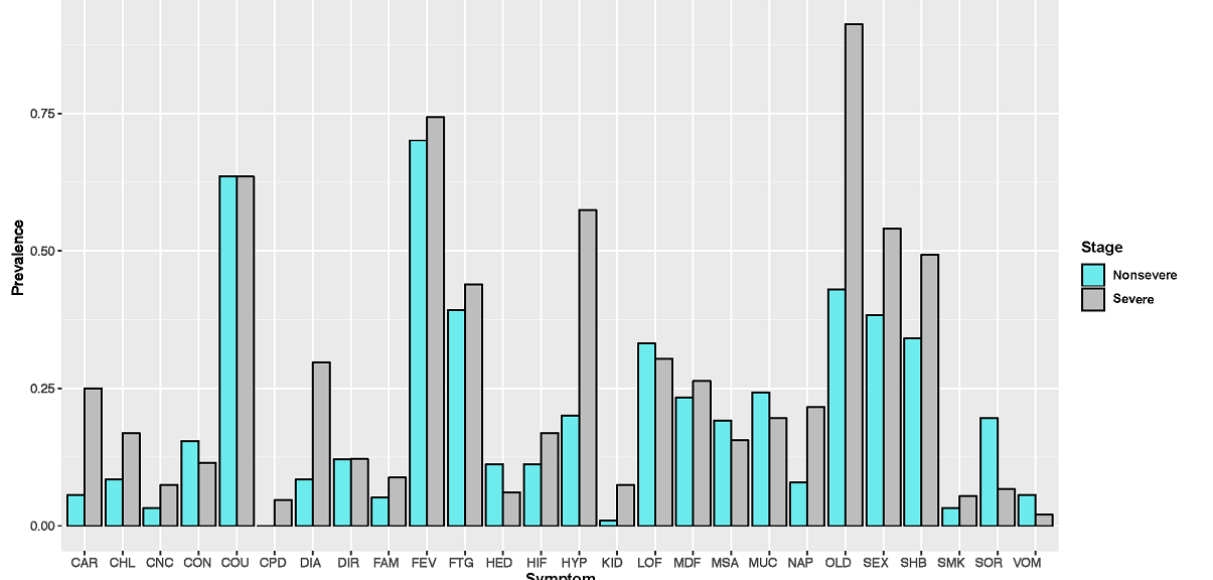
Figure 1. Comparison of clinical features of patients with nonsevere and severe COVID-19. Note that because these features were binary, the y-axis indicates the prevalence of a positive result. CAR: cardiovascular disease; CHL: chills and shaking; CNC: cancer; CON: contact with patients with COVID-19; COU: coughing; CPD: chronic obstructive pulmonary disease; DIA: diabetes; DIR: diarrhea; FAM: family members with